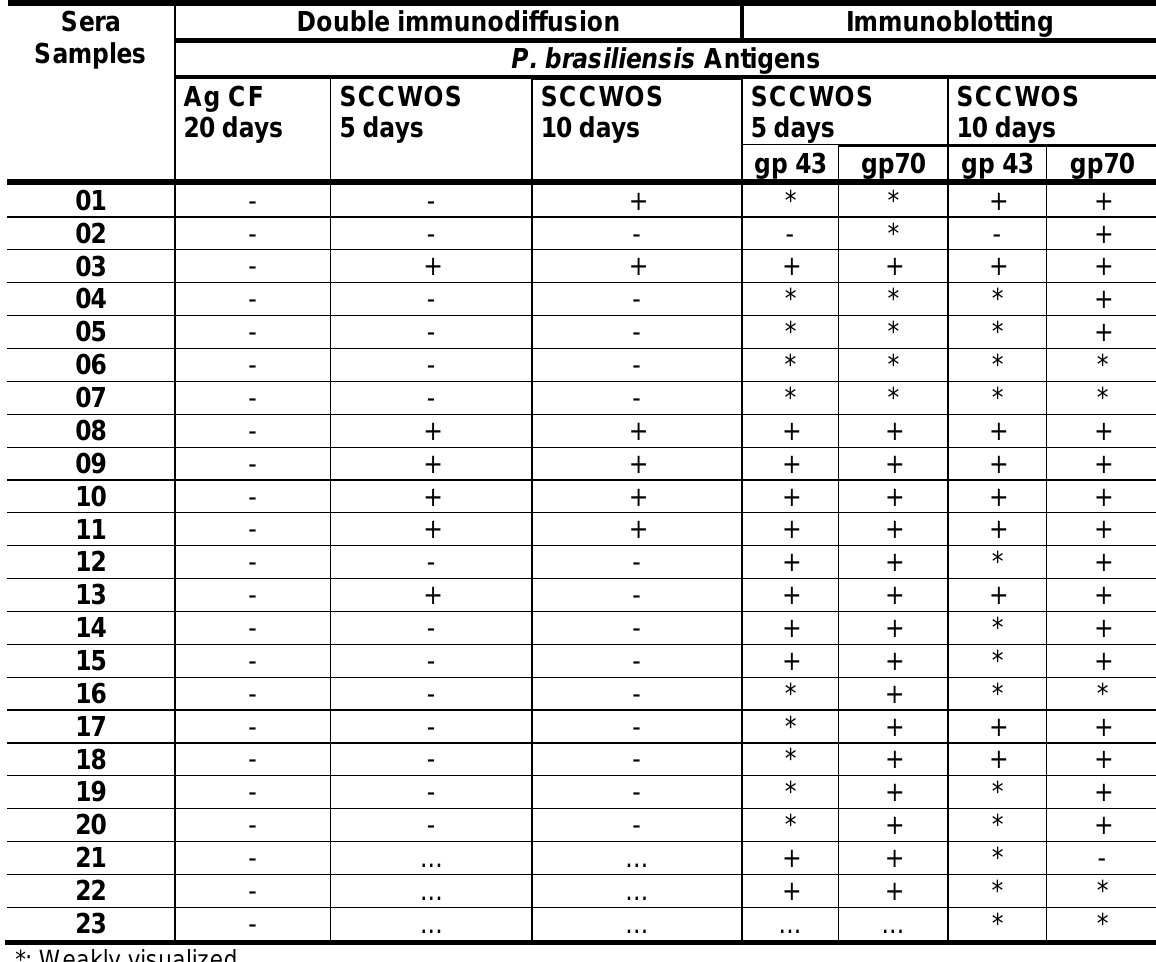
Table 1. Reactivity pattern of paracoccidioidiomycosis sera samples by double immunodiffusion and immunoblotting assays employing culture filtrate antigen (Ag CF) and soluble components of the cell wall outer surface (SCCWOS) of Paracoccidioides brasiliensis antigens obtained from